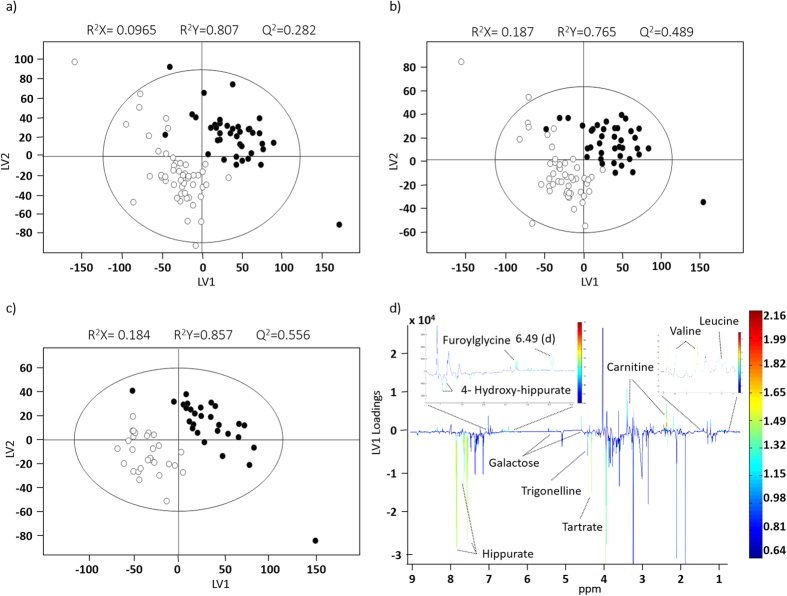
PLS-DA scores scatter plots obtained for the 1H NMR spectra of urine of the unmatched cohort: n = 49 controls (○) vs. n = 39 RCC patients (●), (a) without and (b) with variable-selection; (c) age- and gender-matched sub-cohort: n = 28 controls (○) vs. n = 28 RCC patients (●), with variable-selection; (d) loadings plot corresponding to the model shown in (b). All models were obtained with no. LV = 2. The ellipses indicate the 95% confidence limits. The loadings plots are colored according to variable importance to the projection (VIP) and some assignments are indicated.